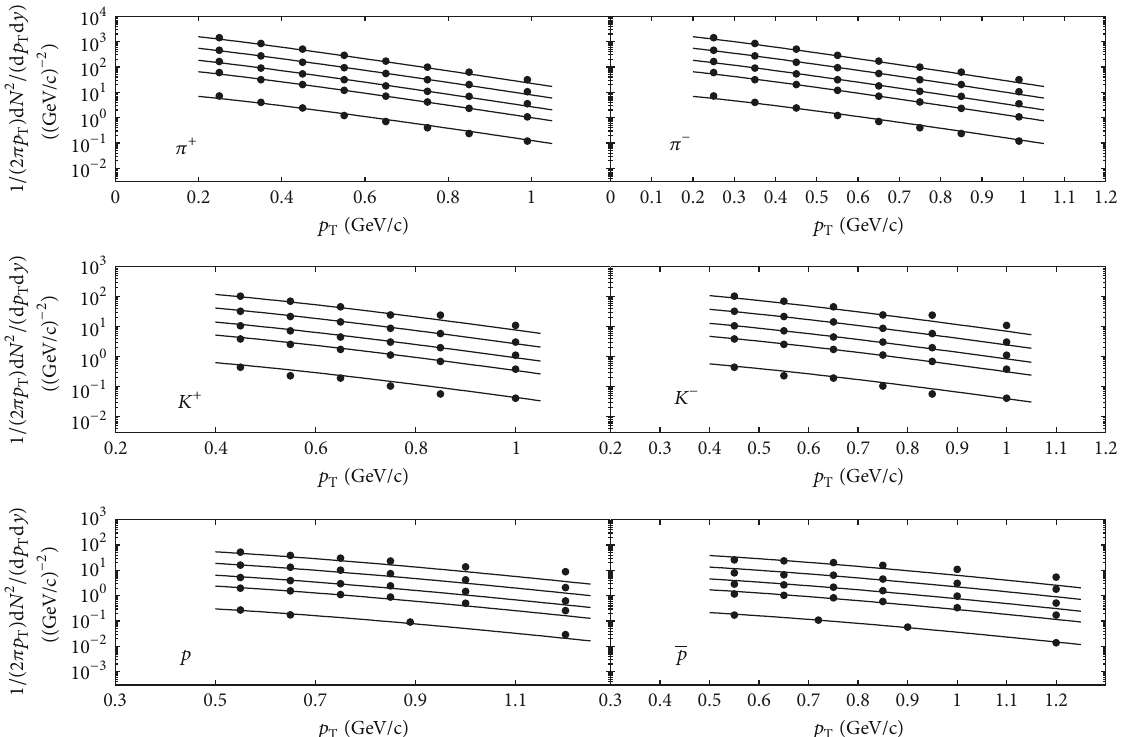
Figure3:Thecentralitydependencesoftransversemomentumdistributionsofidentifiedchargedparticlesproducedatmidrapidityof |𝑦| ≤ 1 in Au-Au collisions at √𝑠 NN = 130 GeV. The solid dots are the experimental data [20]. The solid curves are the hydrodynamic results of (9). The centrality cuts counted from top to bottom in each panel are 0–5% ( × 5), 5–15% ( × 2), 15–30%, 30–60%, and 60–92%, respectively.